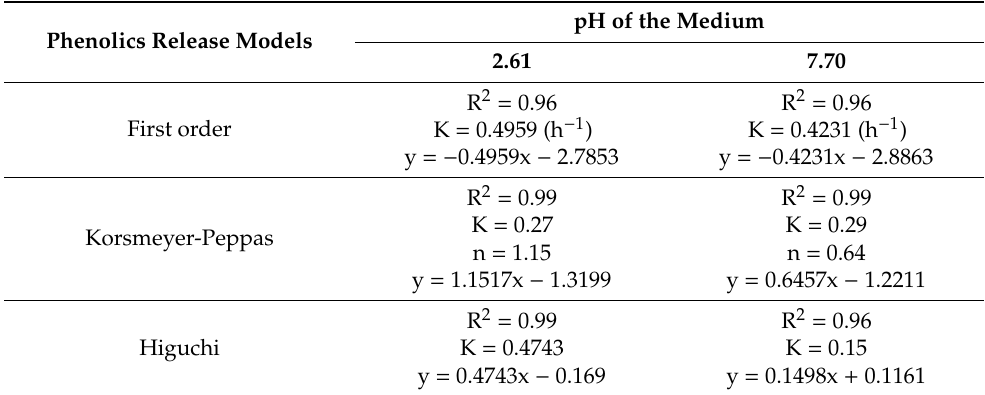
Table 3. Models of the release kinetics of B. dracunculifolia